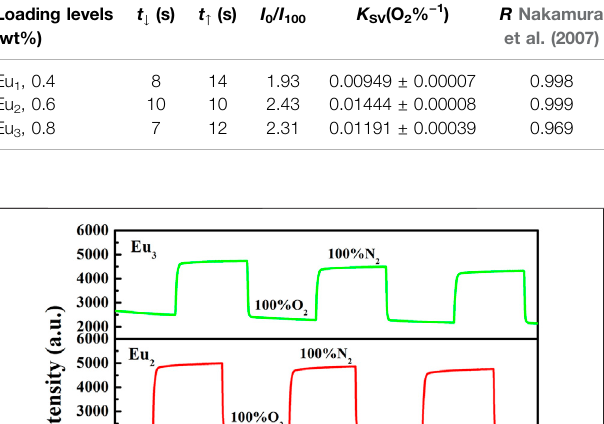
TABLE 1 | Key sensing parameters for Eu 1 , Eu 2 , and Eu 3 . Loading levels (wt%)